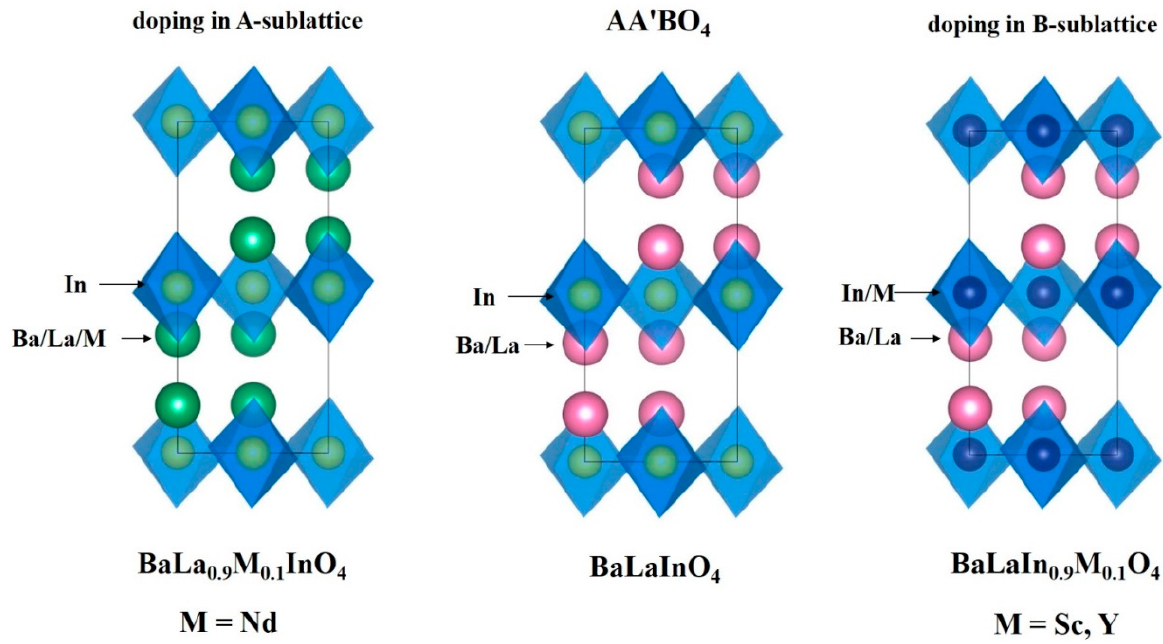
Figure 1. The isovalent substitution representation of BaLaInO 4 .